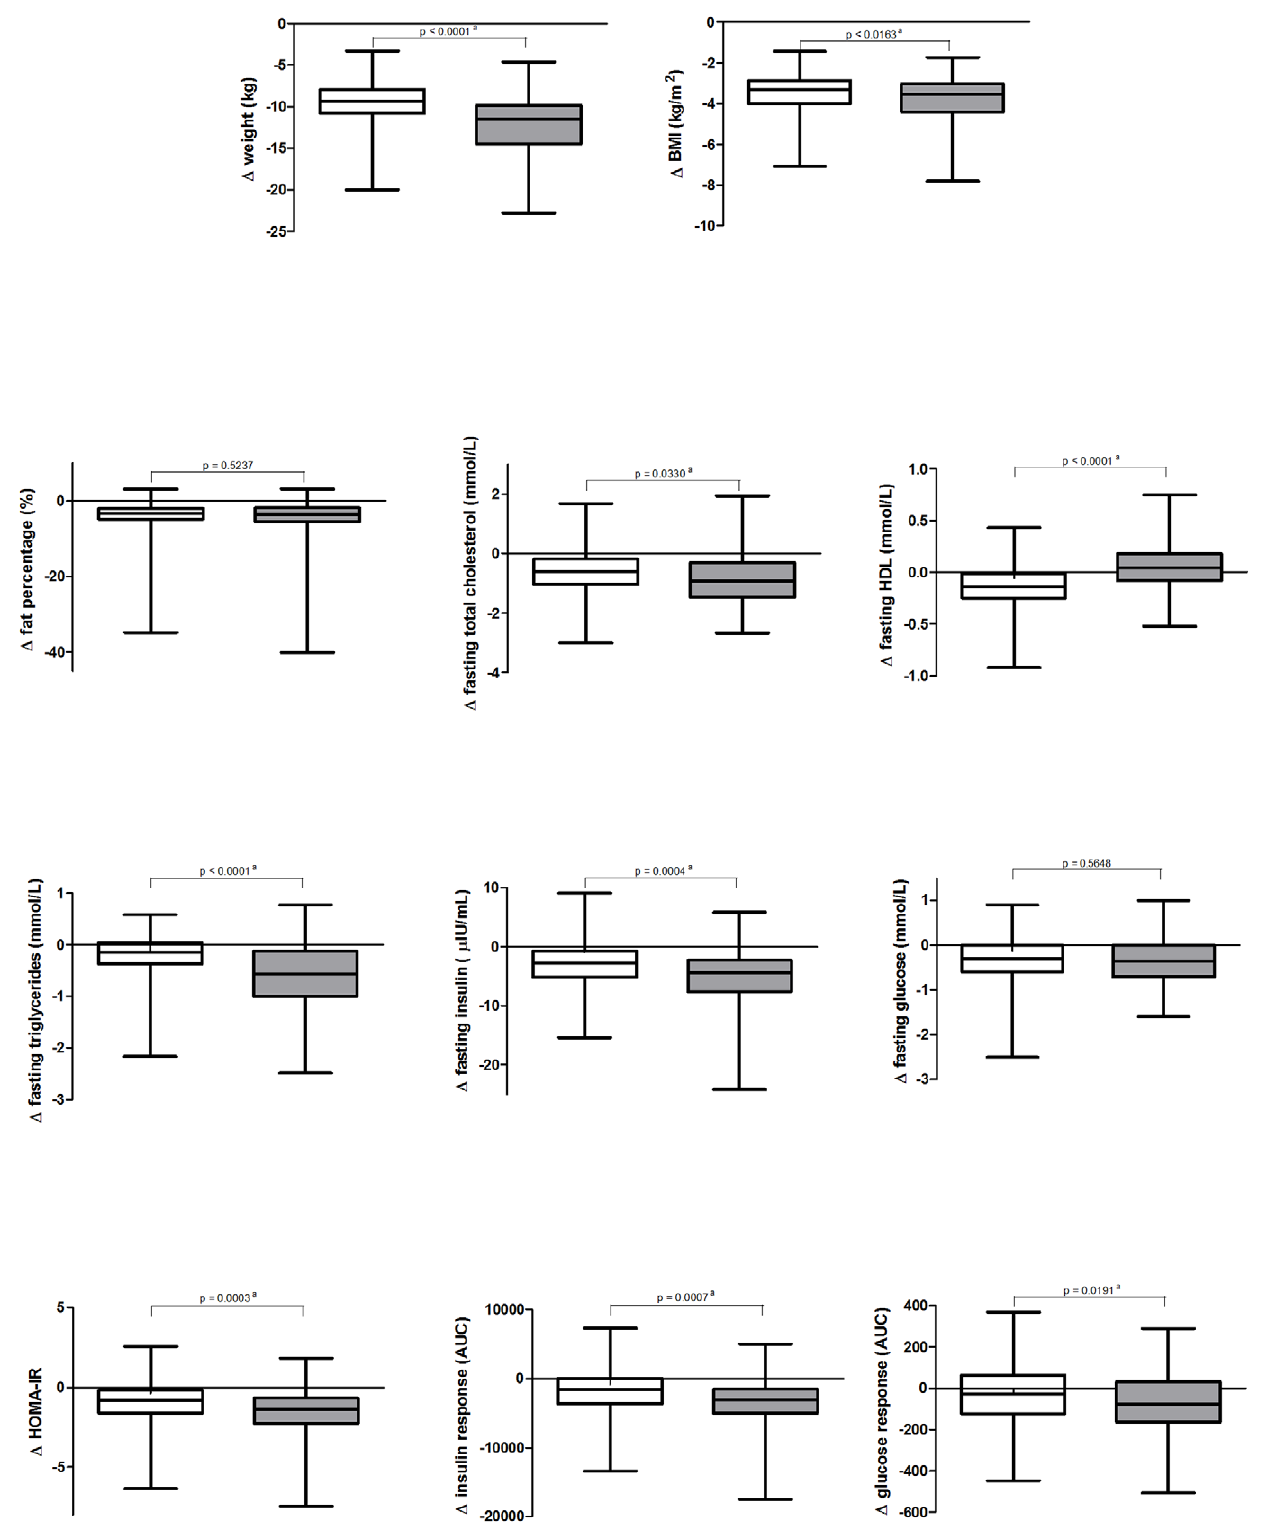
Figure 2. Differences in anthropometric and clinical parameters between women and men. Box plots depicting LCD induced changes (i.e. D CID2-CID1) in anthropometric and clinical parameters for females (white) and males (grey). a p , 0.05 between male and female values when conducting Student’s t-tests was considered statistically significant.